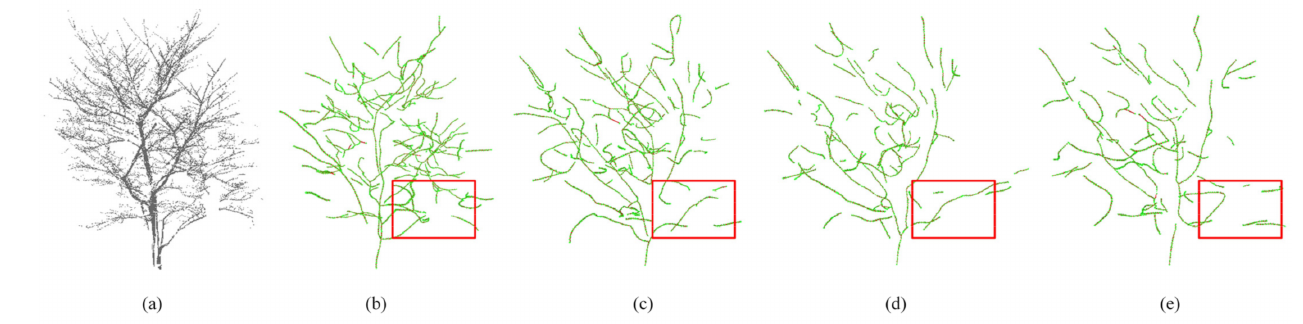
Figure 7. The reconstructed tree models using the different density of point clouds. ( a ) Initial point clouds; ( b ) 100%; ( c ) 70%; ( d ) 50%; ( e )